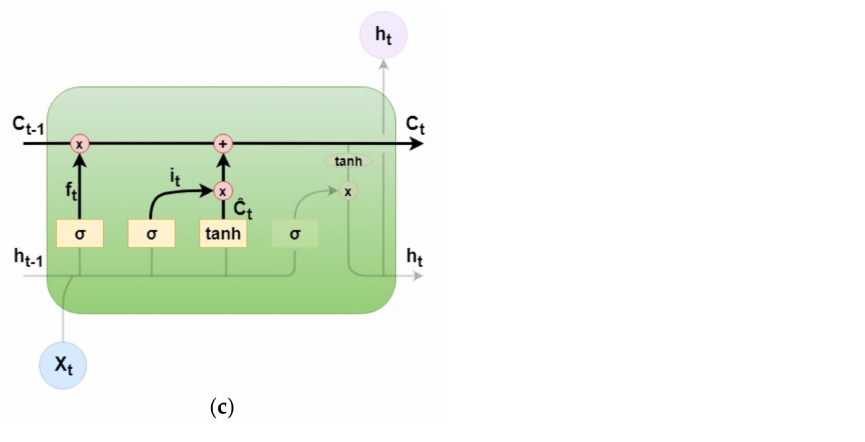
Figure 2. LSTM Cells. ( a ) Forget Gate, ( b ) Input Gate, ( c ) Updating Cell State. The imagination model utilizes the LSTM cell in the text encoder. In the upsampling processes of S i , it utilizes the hidden features h i to reinitialize the cell state in the text encoder. The main difference between the proposed framework and the original framework in [30] is that the imagination model extracts the features again from the text descriptions in every upsampling process. Such design enriches the text features given in the corpus